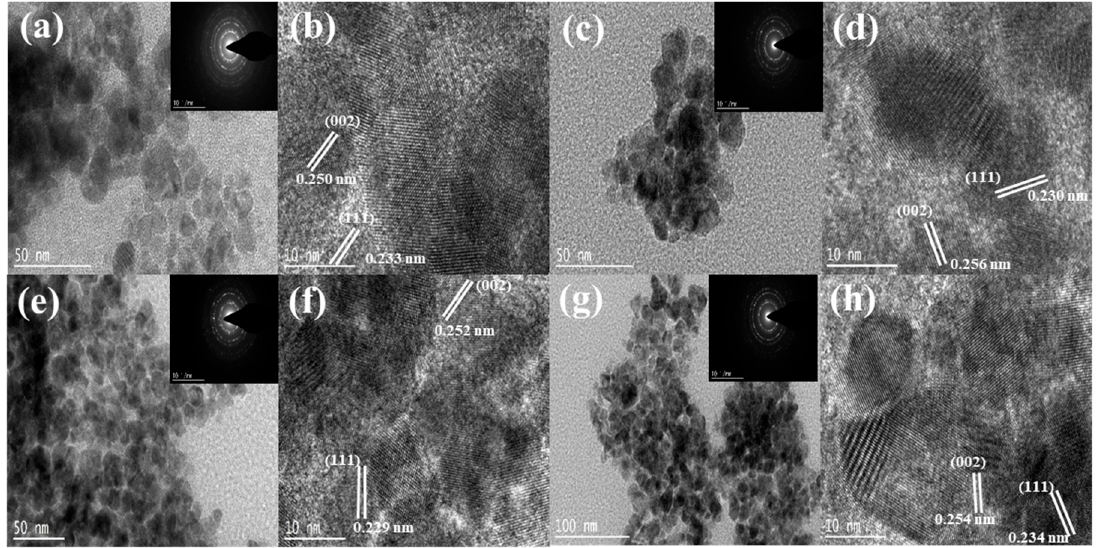
Figure 5. TEM and SAED images of the 15CuO- z Fe 2 O 3 / M-Ce80Zr20: ( a , b ) 15CuO-1Fe 2 O 3 / M-Ce80Zr20, ( c , d ) 15CuO-3Fe 2 O 3 / M-Ce80Zr20, ( e , f ) 15CuO-5Fe 2 O 3 / M-Ce80Zr20, ( g , h )15CuO-7Fe 2 O 3 / M-Ce80Zr20.